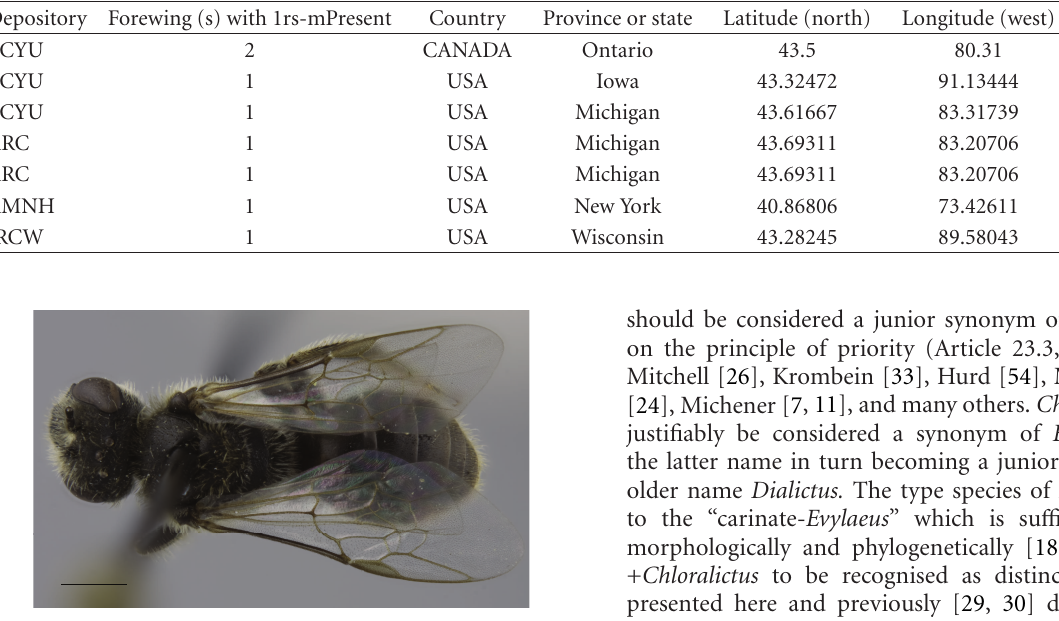
Figure 4: Dorsal habitus of Lasioglossum (Hemihalictus) lustrans with three submarginal cells. Bar =